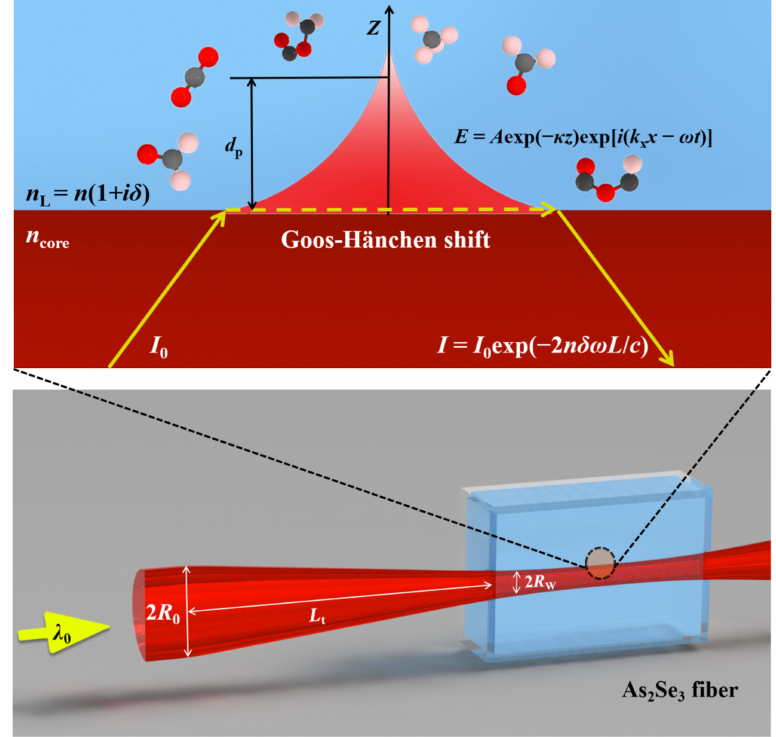
Figure 1. Mathematical model for numerical